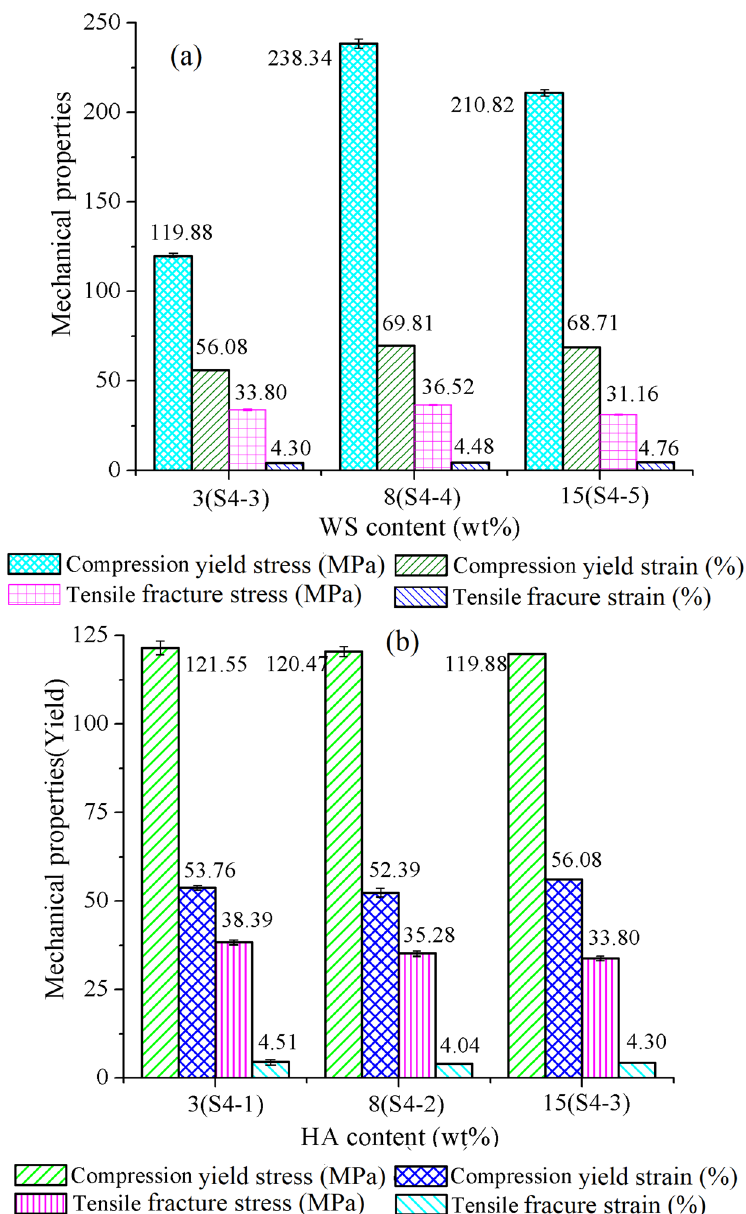
Figure 13. Mechanical properties of FFF PEEK-PLA/WS/HA scaffolds under content effect of: ( a ) WS and ( b )